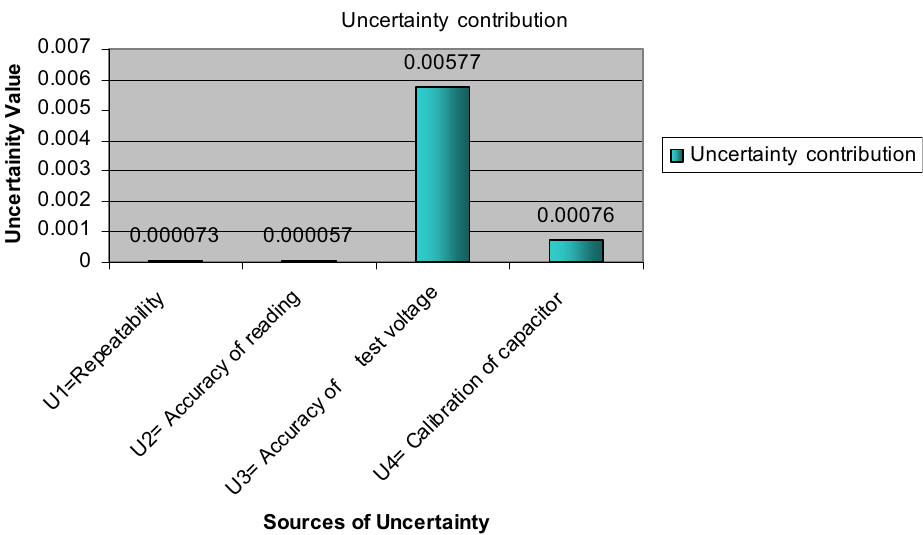
Fig. 7. (Color online) Effects of various factors for Tan Delta.